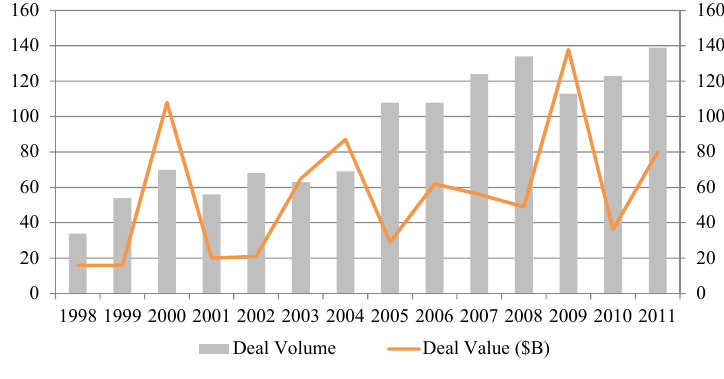
Fig. 2 - Accumulated value and volume of acquisitions in the pharmaceutical market from 1998 to 2011 (in $B and number of transactions). Source: Deutsche Bank Industry Report (2012) However, despite continuous consolidation activities, the level of concentration on the